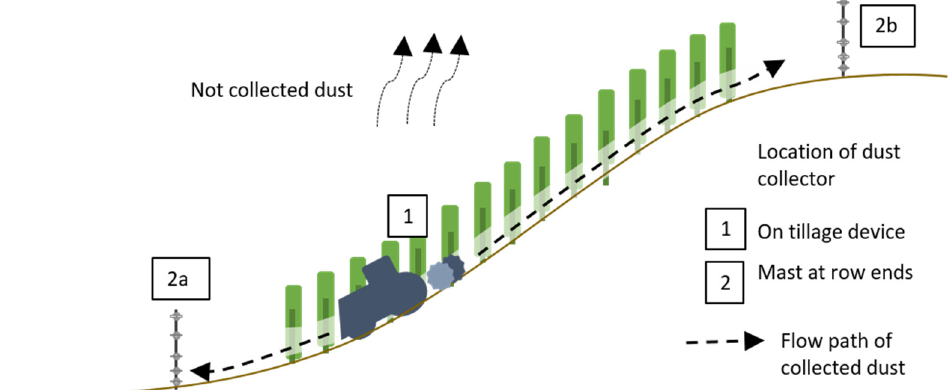
Figure 5. Measurement design and location of dust samplers. Table 1. Total number of samples and